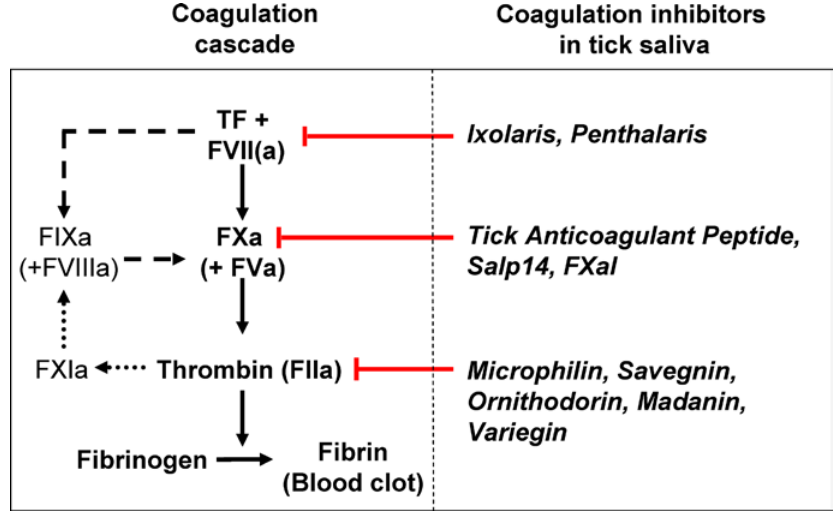
Figure 1. Schematic Overview of the Coagulation Cascade The two major amplification loops in the coagulation cascade are depicted. The first amplification loop consists of TF-FVIIa-mediated factor IX (FIX) activation, which leads to the generation of more FXa. A second amplification loop is formed by the activation of factor XI (FXIa) by thrombin, which results in more activated FIX (FIXa), and, subsequently, additional FXa generation. The right panel indicates how selected tick proteins exert their anticoagulant effect. FIIa, activated factor II; FVa, activated factor V; FVIIIa, activated factor